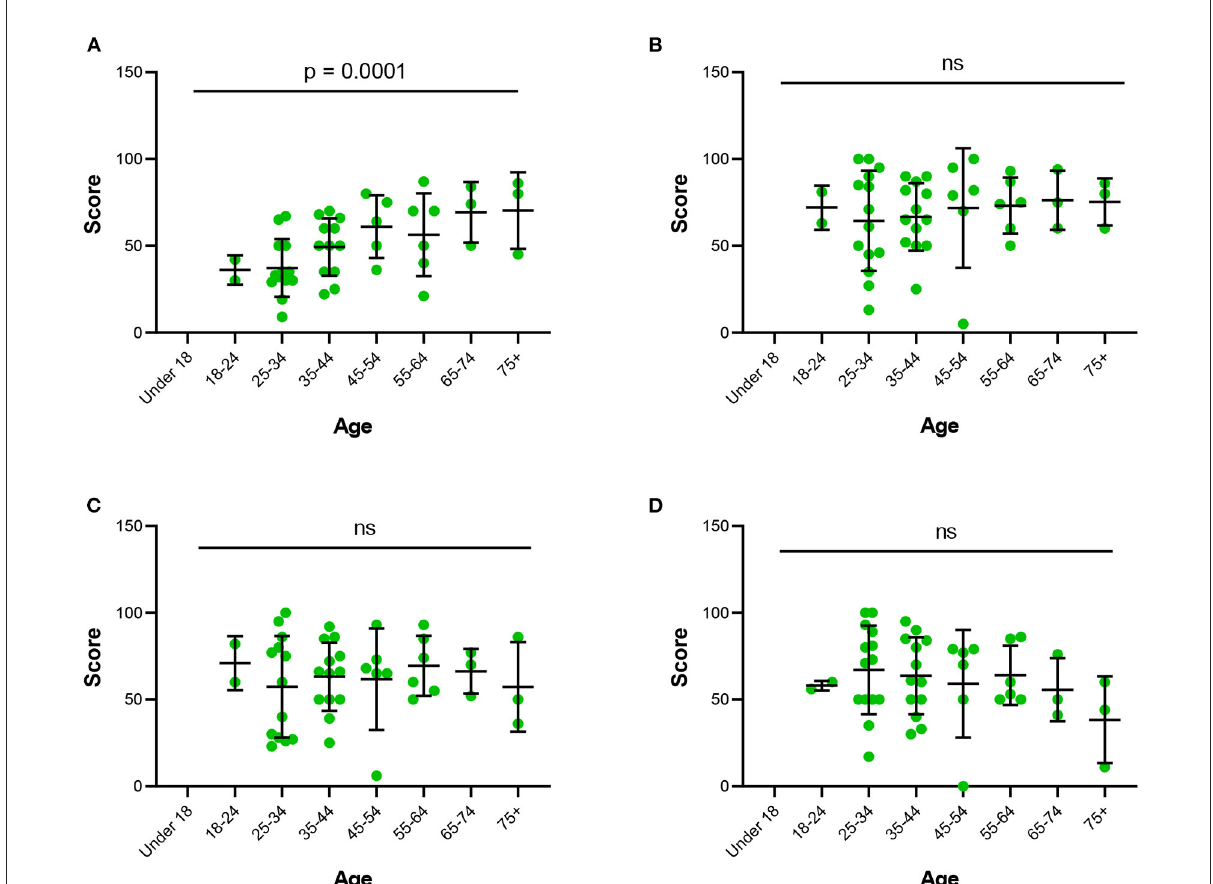
FIGURE4 Individual scores from the post-conference survey based on attendee’s age. Individual scores from the post-conference survey addressing (A) expectation, (B) satisfaction, (C) confidence, and (D) navigation based on attendee’s age. Error bars represent standard errors of mean. Statistical analysis by Spearman’s rho correlation coefficient [ (A) : p = 000.1, (B) : p = 0.434, (C) p = 0.779, (D) p = 0.199]. ns, not significant represents a p -value >